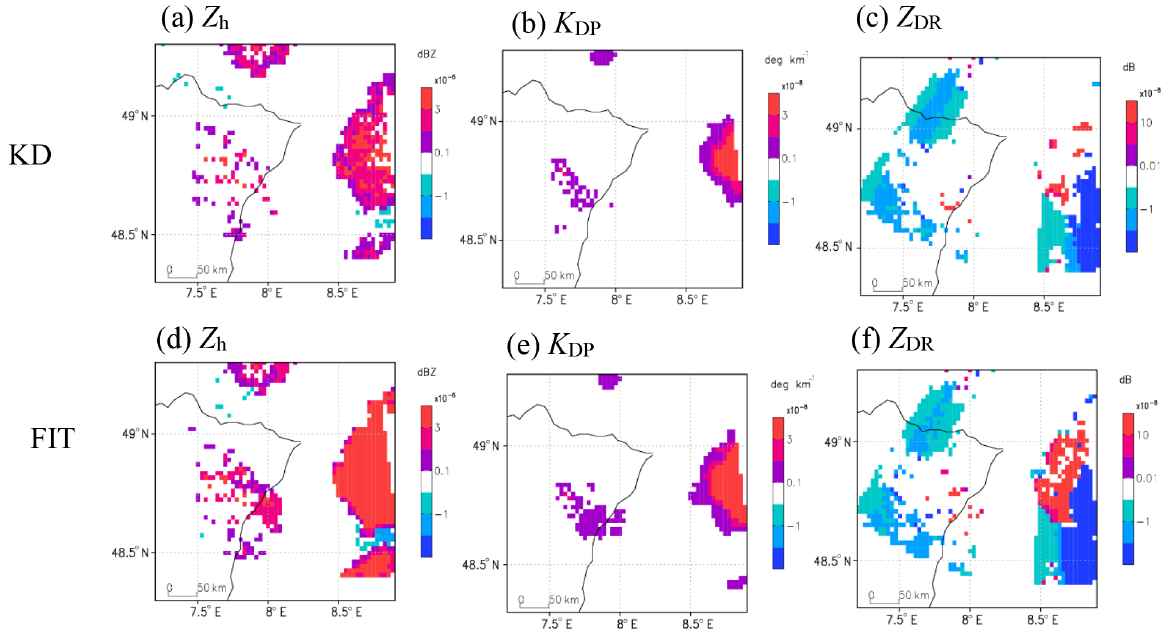
Figure 3. Horizontal distributions of differences in polarimetric parameters between assimilation results by KD and FIT with WRF 3D-Var and observations at 11:00UTC on 14 August